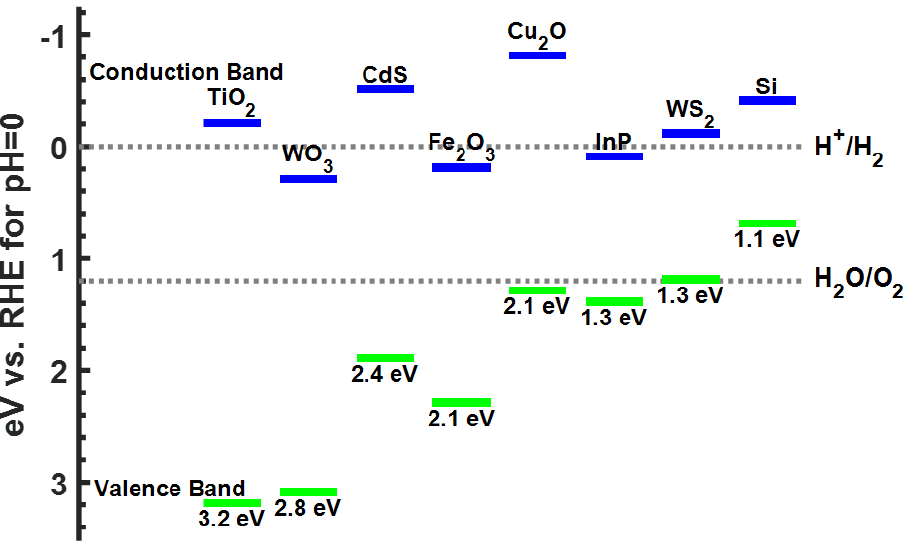
Figure 6. Band edge position for different material systems proposed for water splitting, where RHE is reversible hydrogen electrode, and band gap potentials are shown. Values from [49].